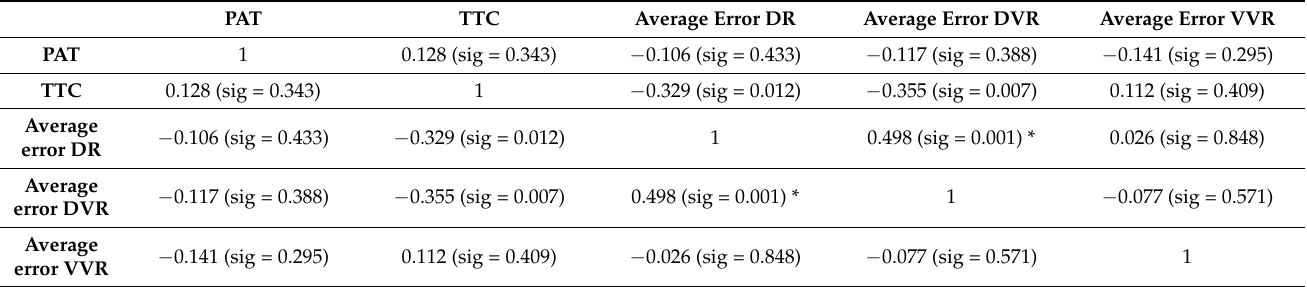
Table 4. Significance level of the Kolmogorov–Smirnov test for each numerical explaining variable. PAT TTC <0.001 0.0388 0.2 Table 5. Correlation values for continuous explaining